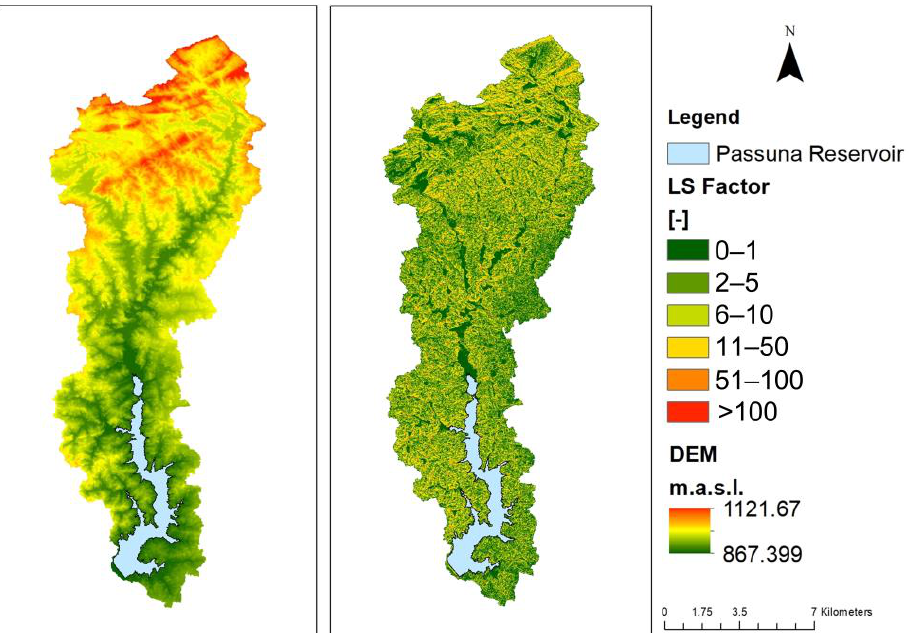
Figure 2. ( Left ) . Digital elevation model; ( Right ) spatial distribution of LS Factor. Figure 2. ( a ) . Digital elevation model; ( b ) spatial distribution of LS Factor.